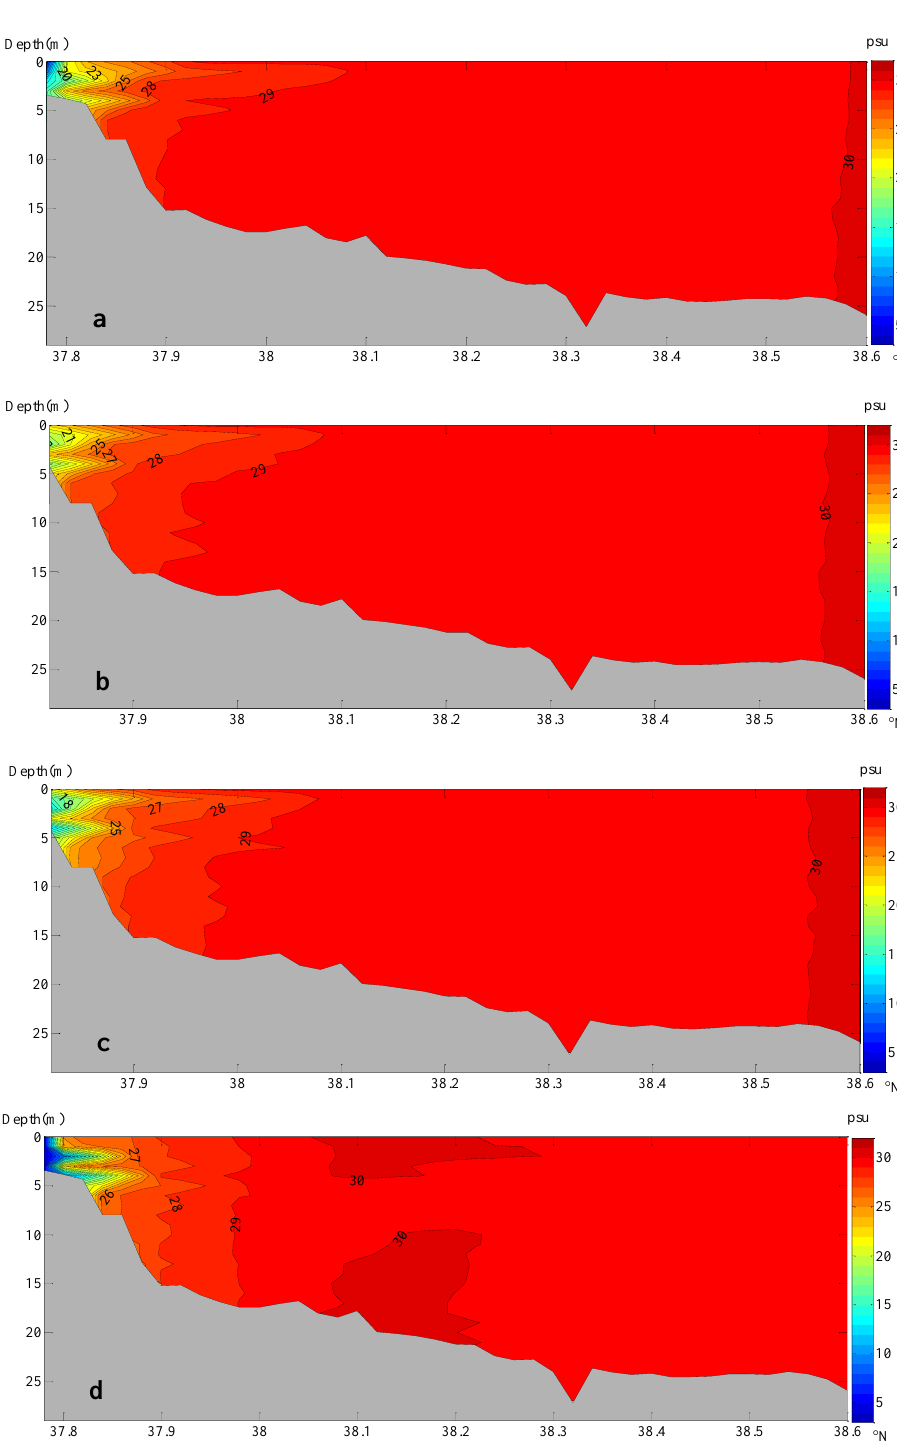
Figure 16. Surface salinity distribution at different wind speeds in the dry season (( a ): case 3, ( b ): case 4, ( c ): case 5, ( d ): case 6).